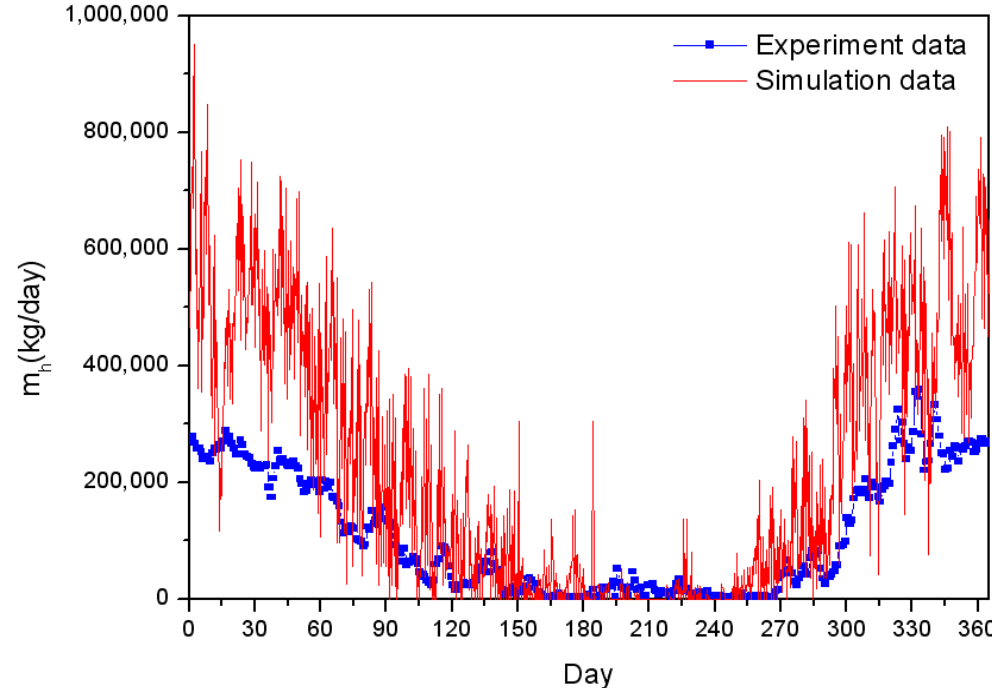
Figure 17. Comparison of mass flow rate of group energy apartment building with original heating system and that with the optimal heating system for a